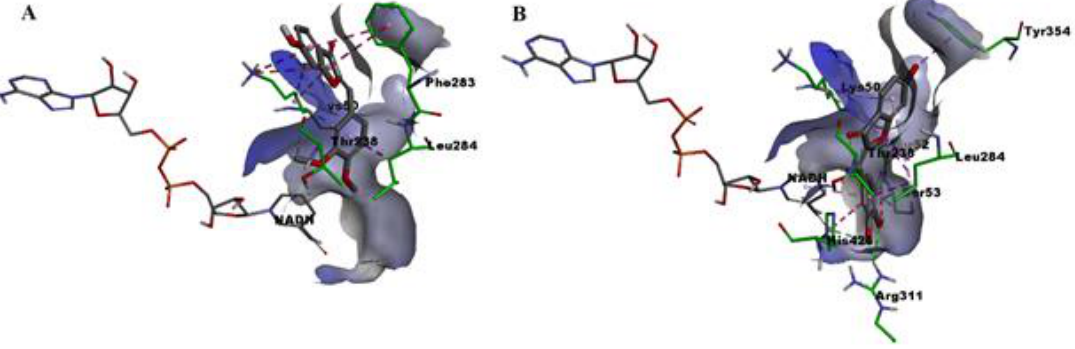
Figure 3. Sequence alignment and Ramachandran plot of the generated homology model of L. donovani NADH-dependent fumarate reductase: ( A ) Sequence alignment against chain A of S. frigidimarina fumarate reductase (PDB code: 2b7s) showing predicted secondary structures according to dictionary of secondary structure of protein (DSSP); ( B ) Ramachandran plot of ϕ / ψ of amino acid residues of the generated homology model indicated that most of them are located in the favored regions.